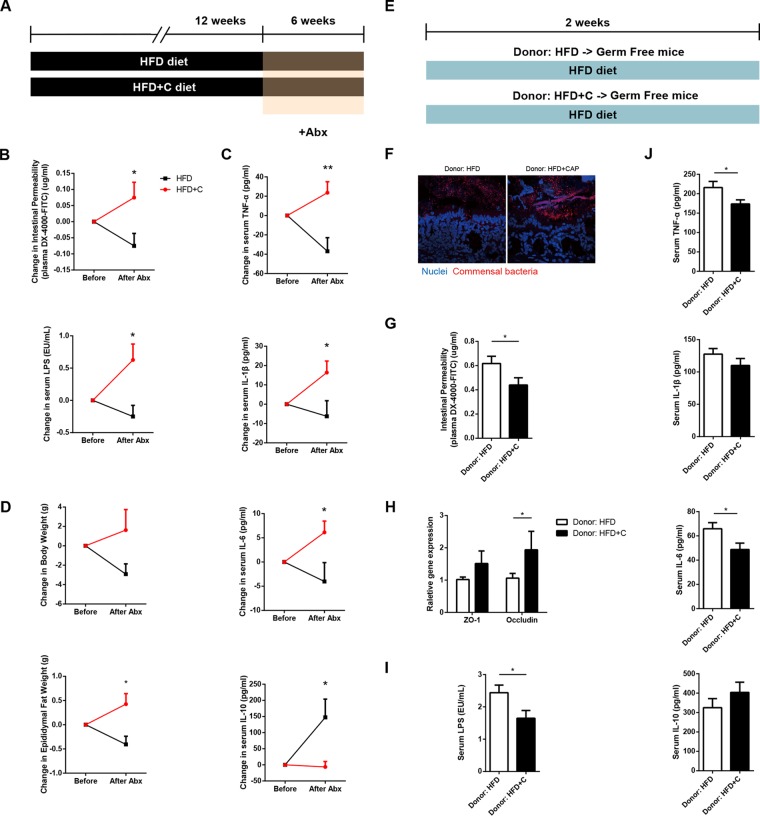
Gut microbiota mediates the preventive effects of CAP on metabolic endotoxemia. (A) Schema showing the animal groups and treatments. Male WT mice (n = 6/group) received either HFD±C (A) or NCD±C (Fig. S5) for 12 weeks and then were treated with a broad-spectrum antibiotic cocktail (Abx) consisting of ampicillin, vancomycin, neomycin sulfate, and metronidazole for 6 weeks to introduce microbiota depletion (A). Blood and tissue samples were subjected to various analyses, and data were analyzed before and after Abx supplementation for markers of metabolic endotoxemia (B), systemic chronic low-grade inflammation (CLGI) (TNF-α, IL-1β, IL-6 and IL-10) (C), and obesity (D). (E) Schema showing the germfree mice that received microbiota transplanted from mice treated with HFD±C for 12 weeks. Two weeks after transplantation, blood and tissue samples were subjected to various analyses, such as FISH for markers of bacterial translocation, metabolic endotoxemia, and bacterial invasion of epithelium (F), gut permeability (G), intestinal tight junction proteins (H), plasma levels of LPS (I), and plasma levels of markers of systemic CLGI (J). Data are expressed as means ± SEM, and statistical analysis was performed using ANOVA with a post hoc Bonferroni’s multiple-comparison test or unpaired two-tailed Student’s t test.